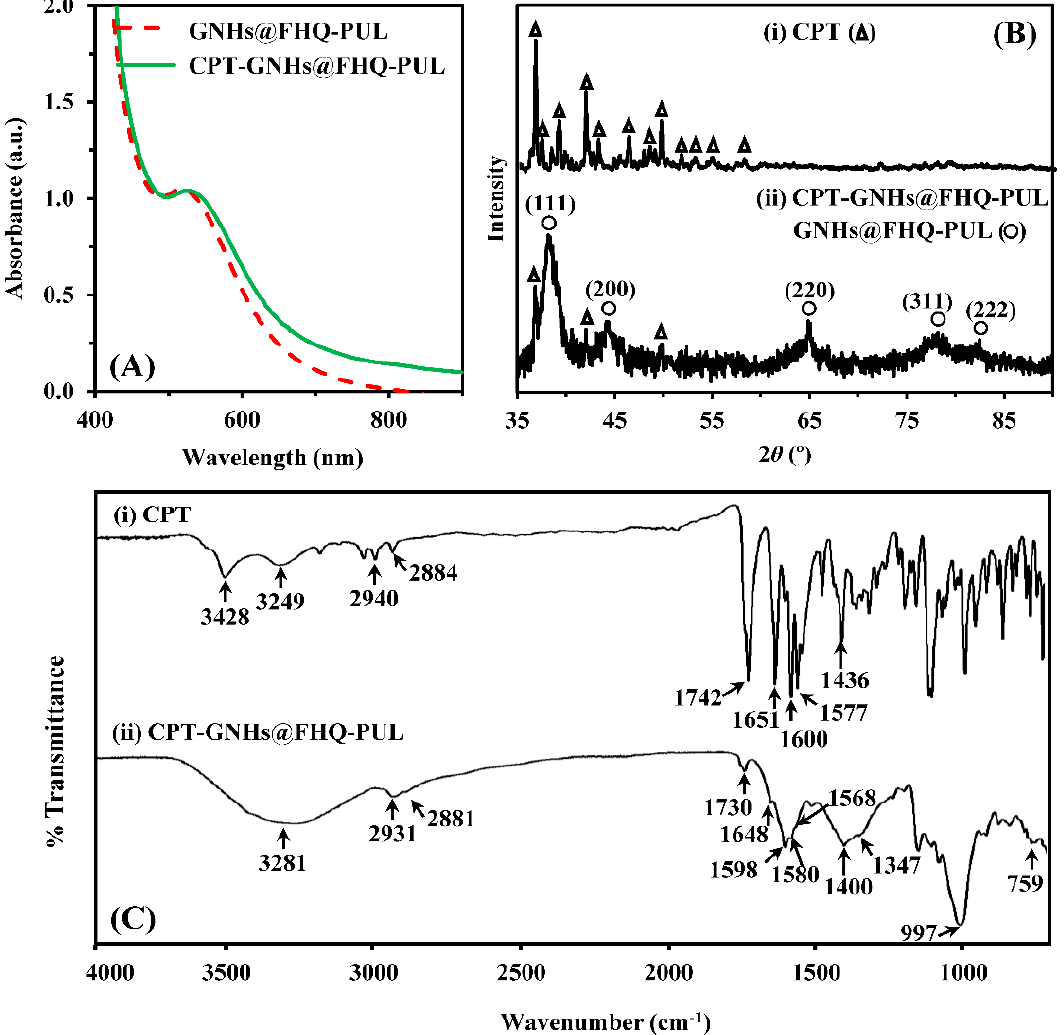
Figure 3. ( A ) UV-vis spectra of GNHs@FHQ-PUL and CPT-GNHs@FHQ-PUL. ( B ) XRD patterns and ( C ) ATR-FTIR spectra of CPT-GNHs@FHQ-PUL compared to CPT.